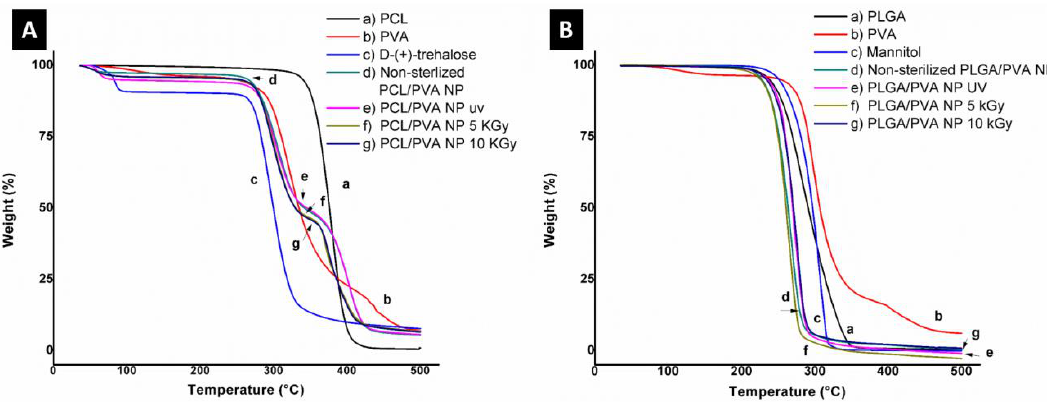
Figure 3. ( A ) Thermogram of the PCL/PVA NP system; (a) PCL, (b) PVA, (c) trehalose, (d) non-sterilized PCL/PVA NP, (e) PCL/PVA NP after UV radiation, (f) PCL/PVA NP after 5 kGy of gamma radiation, and (g) PCL/PVA NP after 10 kGy of gamma radiation. ( B ) Thermogram of the PLGA/PVA NP system; (a) PLGA, (b) PVA, (c) mannitol, (d) non-sterilized PLGA/PVA NP, (e) PLGA/PVA NP after UV radiation, (f) PLGA/PVA NP after 5 kGy of gamma radiation, and (g) PLGA/PVA NP after 10 kGy of gamma radiation.